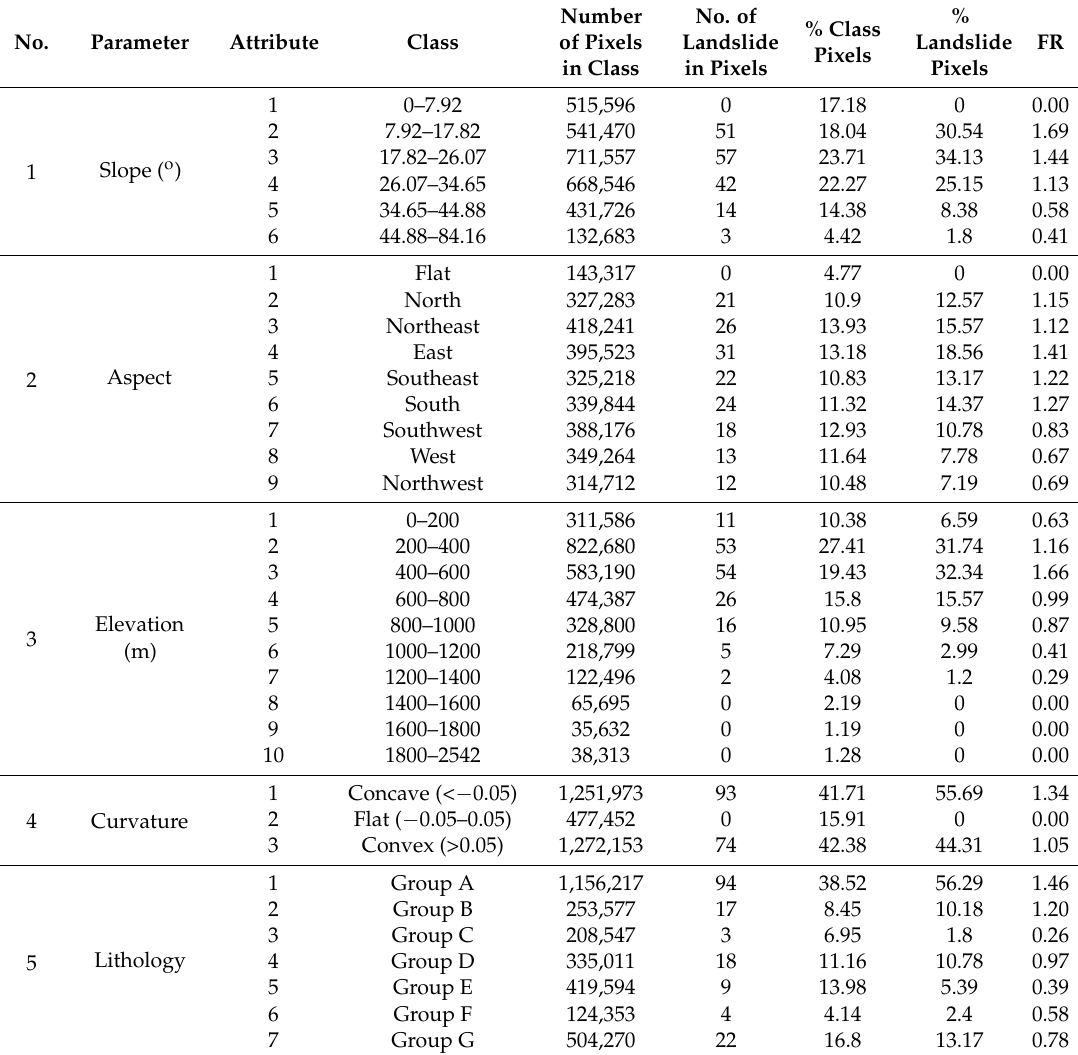
Figure 4. Thematic maps of the study area: ( A ) Slope, ( B ) distance to faults, ( C ) curvature, ( D ) slope aspect map, ( E ) slope length, ( F ) distance to rivers, ( G ) elevation, ( H ) distance to roads, ( I ) lithology, ( J ) valley depth, ( K ) TWI, and ( L ) TRI. Table 2. Analysis of frequency of landslides on the thematic maps.